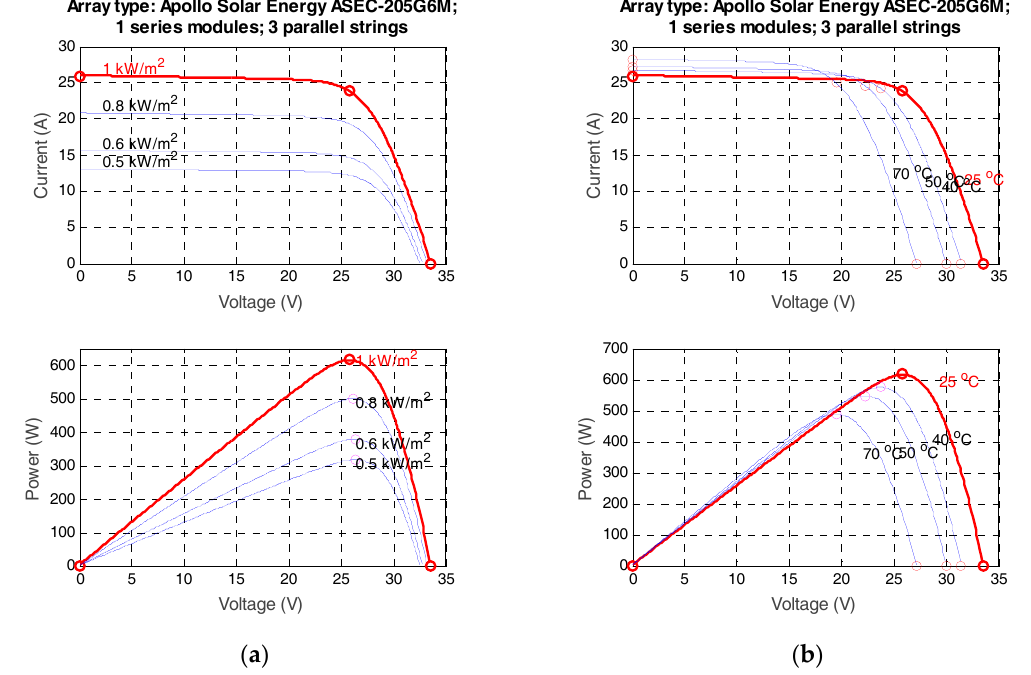
Figure 2. ( a ) P – V and I – V curves for different irradiance and constant T; ( b ) P – V and I – V curves for different temperatures and constant G.